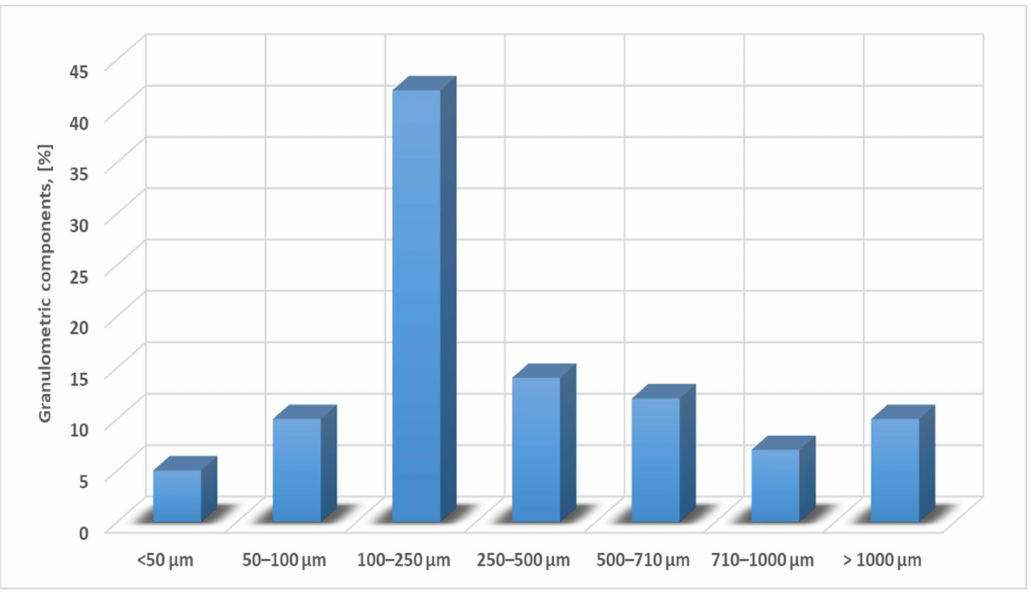
Figure 5. Particle size composition of sludge mill scale.